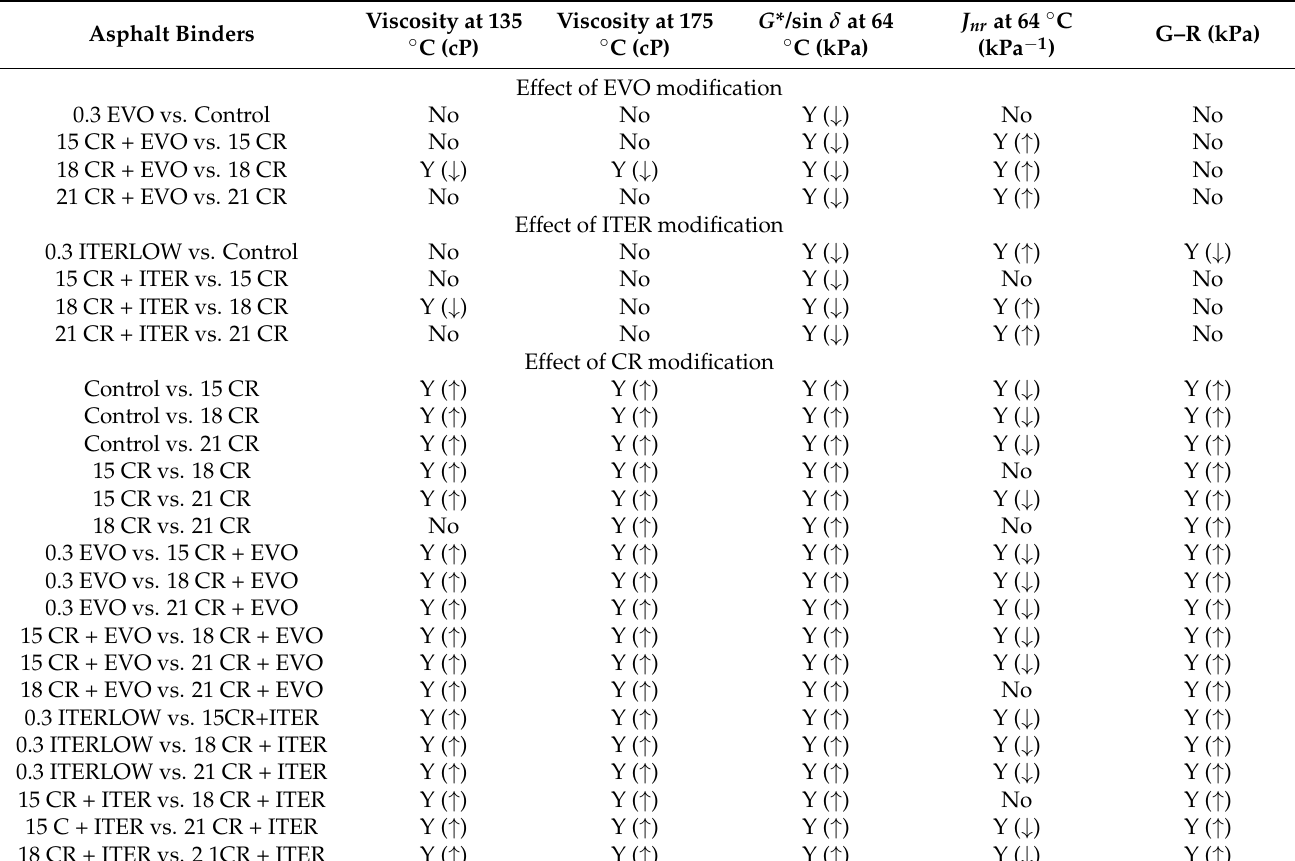
Table 6. Statistical analysis of rheological